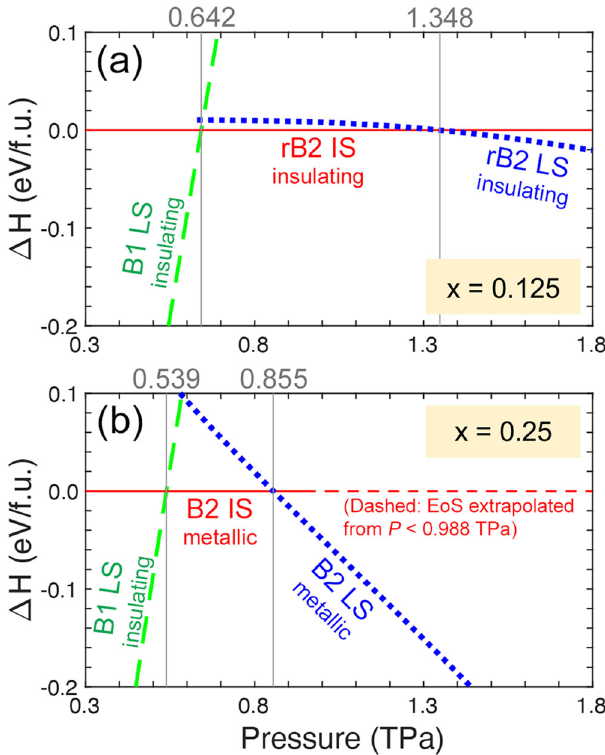
Fig. 6 Relative enthalpies of (Mg 1 − x Fe x )O in various structural phases and spin states. a x = 0.125, with the rB2 intermediate-spin (IS) state as the reference; b x = 0.25, with the B2 IS state as the reference. The vertical lines and the numbers above indicate the enthalpy crossings and transition pressures, phase 22,49 – 54 . For x = 0.25 (Fig. 6b), a simultaneous structural, spin, and metal – insulator transition occurs at 0.539 TPa, from the insulating B1 LS state to the metallic B2 IS state (notice that S increases). Upon further compression, an IS – LS transition occurs